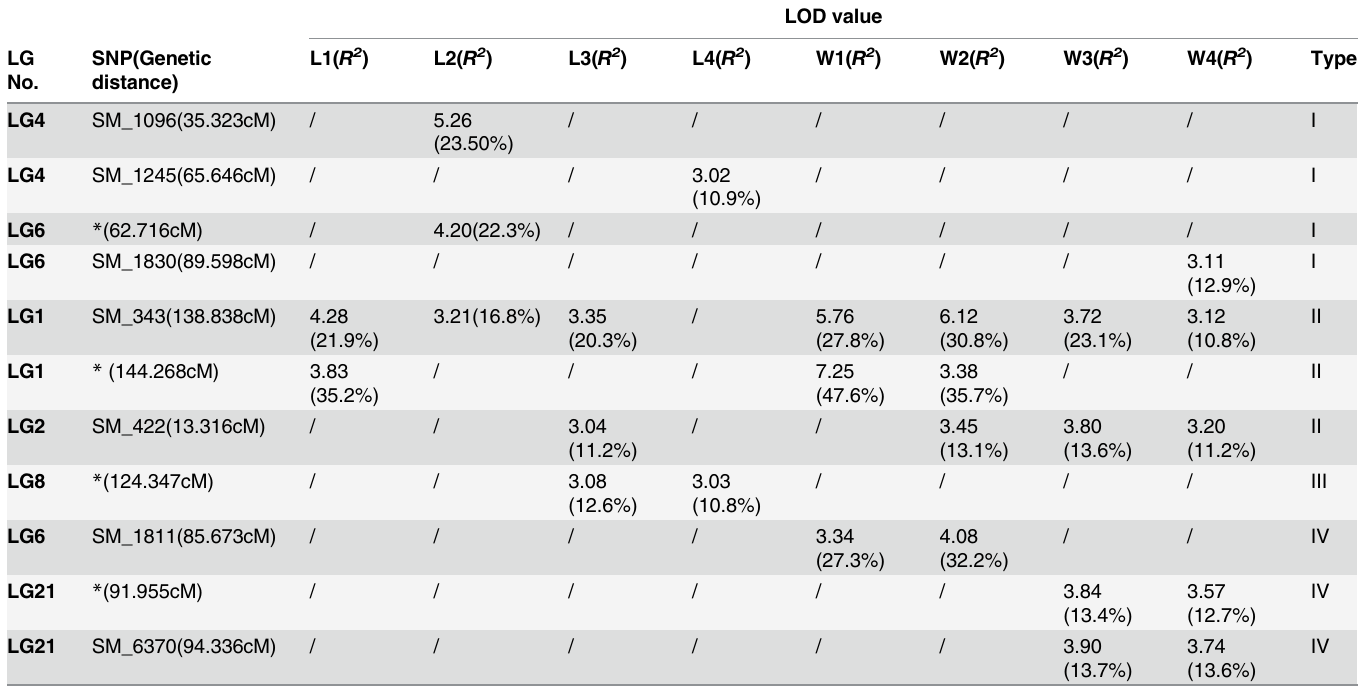
* represents the QTLs are located between two contiguous linked SNPs; / means the LOD score was < 3.0; L1 – L4 and W1 – W4 represent traits of body length and body weight at four growth periods, R 2 represents phenotypic variance explanation